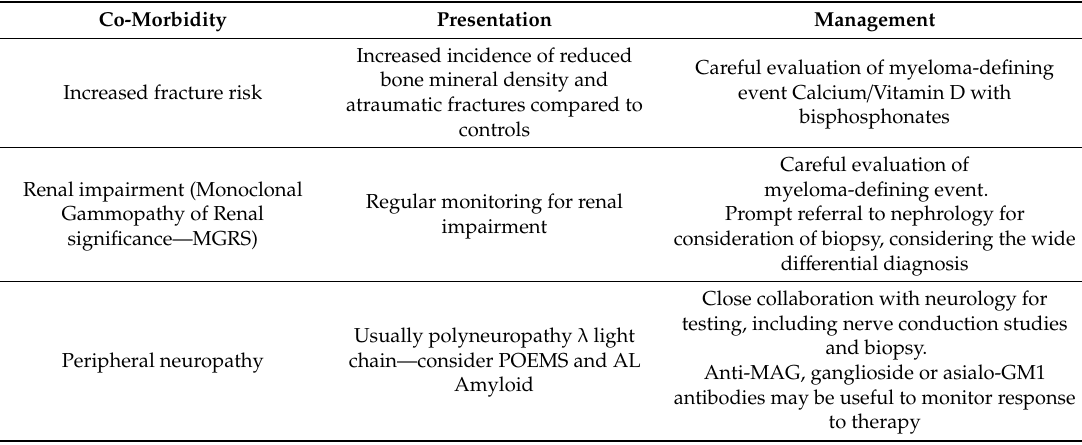
Table 2. Summary of the presenting features and principles of management of co-morbidities associated with